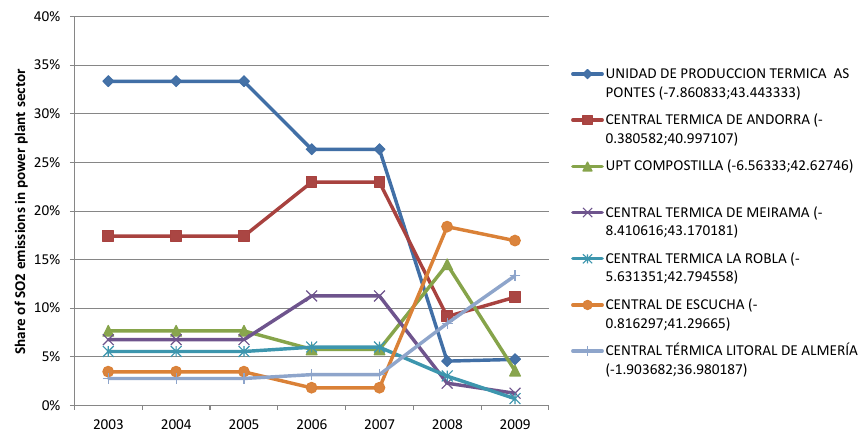
Figure 12. Contribution of the top-7 SO 2 emitting power plants in Spain in 2003 to the annual total SO 2 emissions from the power plant